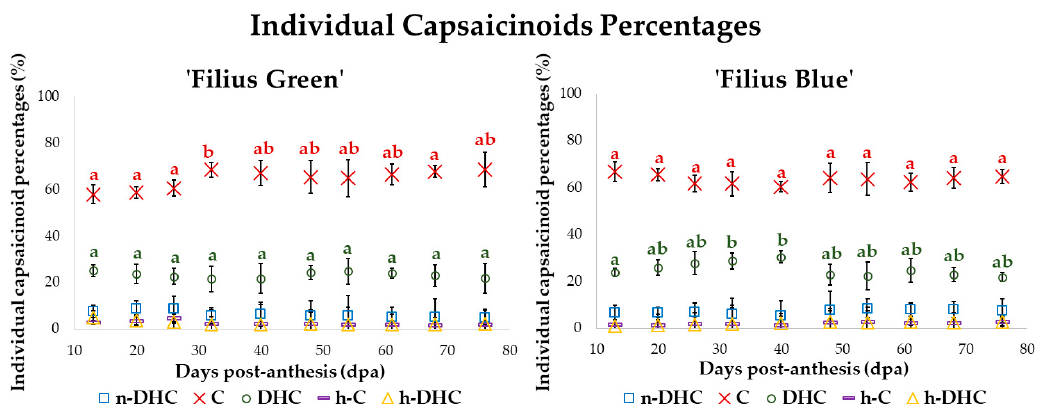
Figure 4. Individual capsaicinoid percentages (%) during the fruit ripening ( n = 2). The same letter has been assigned in this figure to indicate that there are no significant di ff erences according to Tuckey’s test, that is, both values have a p -value > 0.05. In addition, a di ff erent letter color has been assigned to each specific capsaicinoid, i.e., blue for nordihydrocapsaicin (n-DHC), red for capsaicin (C), green for dihydrocapsaicin (DHC), purple for homocapsaicin (h-C), and yellow for homodihydrocapsaicin (h-DHC). Significant di ff erences in the two major capsaicinoids have been highlighted to improve readability.